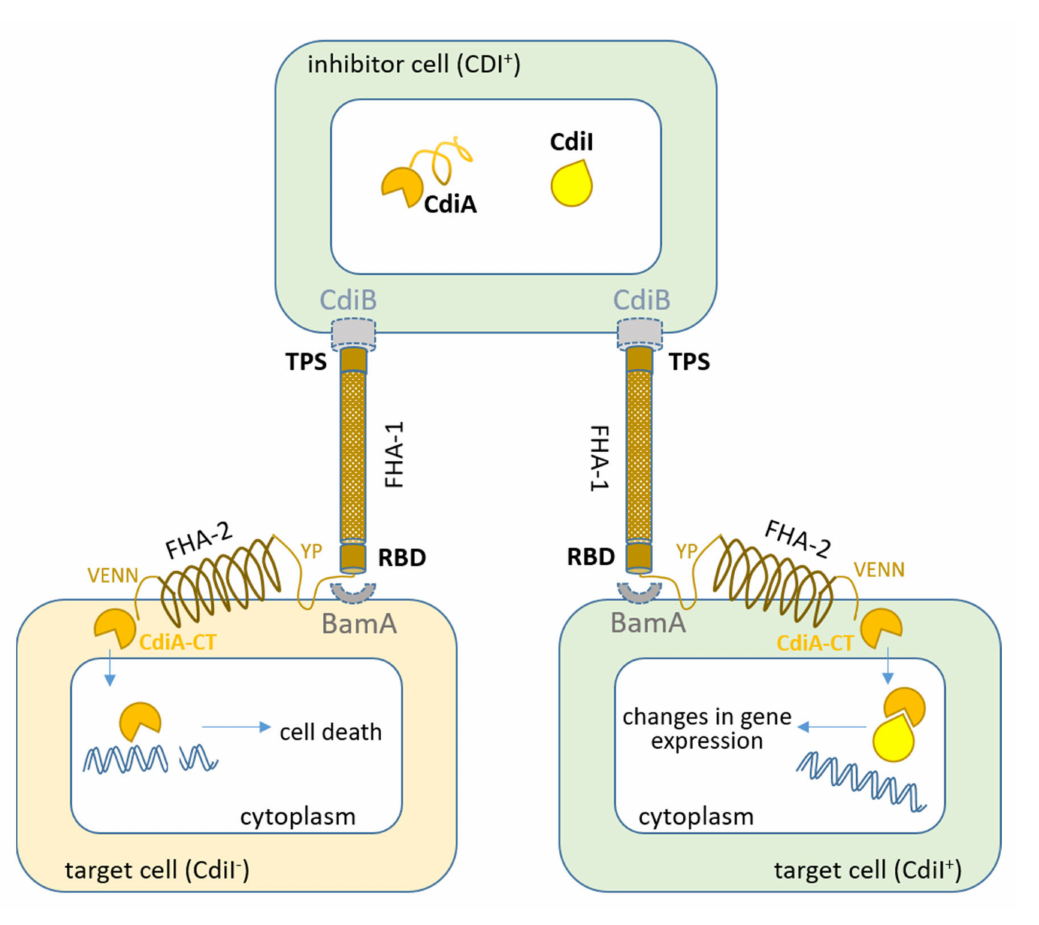
Figure 2. The contact-dependent growth inhibition (CDI) model of toxin delivery into a neighboring cell. The C-terminal e ff ector domain (CdiA-CT) (toxin) is delivered to the target cell via specific membrane receptors (left part of the figure). In the cytoplasm, CdiA-CT degrades the nucleic acids (DNA or RNA) of the target cell leading to growth arrest and cell death. When entering a cell that produces CDI proteins (right part of the picture), CdiA-CT is inactivated by binding to the corresponding immune proteins CdiI. It was assumed that the complex of CdiA-CT / CdiI with nucleic acids and / or target cell proteins induces changes in gene expression leading to phenotypic changes